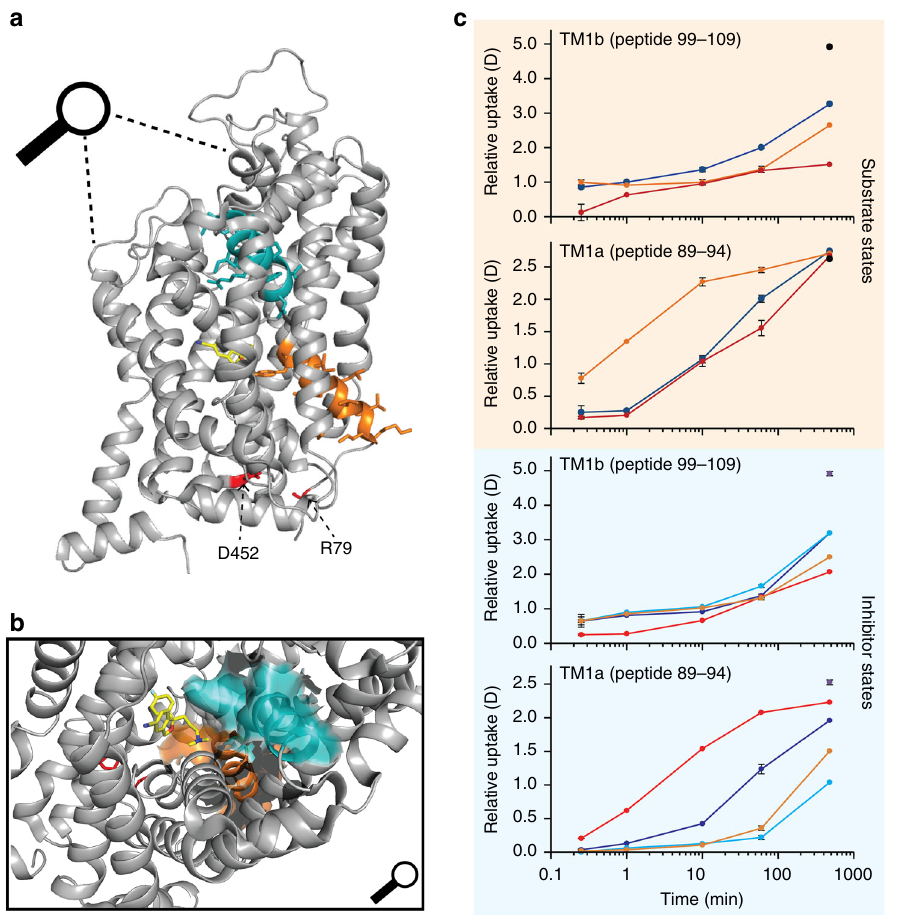
Fig. 5 Differences in dynamics of TM1 in hSERT upon binding of ions, 5-HT and drugs ( a ). TM1a (orange), and TM1b (cyan) highlighted in the structure of hSERT (PDB: 5i75) along with Arg79 and Asp452 (residues shown red) which form the conserved salt bridge between the N-terminal domain and TM8, respectively. A magnifying glass gives an approximation of the angle for the zoom-in view of the central binding cavity. b Central binding cavity occupied by S-citalopram (carbons yellow, oxygen red, and nitrogen blue). In this zoom-in view, the surface of TM1a and TM1b are shown as orange and cyan, respectively. c Deuterium uptake plots for two peptides located in TM1a (peptide 89 – 94) or TM1b (peptide 99 – 109) in the presence of Na + (blue), K + (orange), and 5-HT (red) (brown box) or in the absence (blue, Na + -reference state) and presence of the inhibitors cocaine (cyan), ibogaine (red), or S- citalopram (orange) (blue box). Error bars indicate standard deviations for time points measured in replicates ( n = 2 – 4). Maximum-labelled controls are indicated with a black dot. Source data for the HDX data are provided as a Source data fi